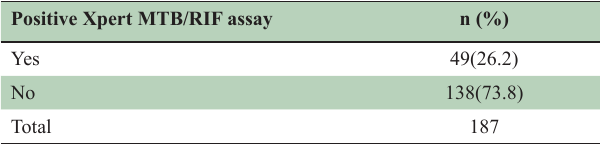
Table-III: Frequency distribution of positive Gene